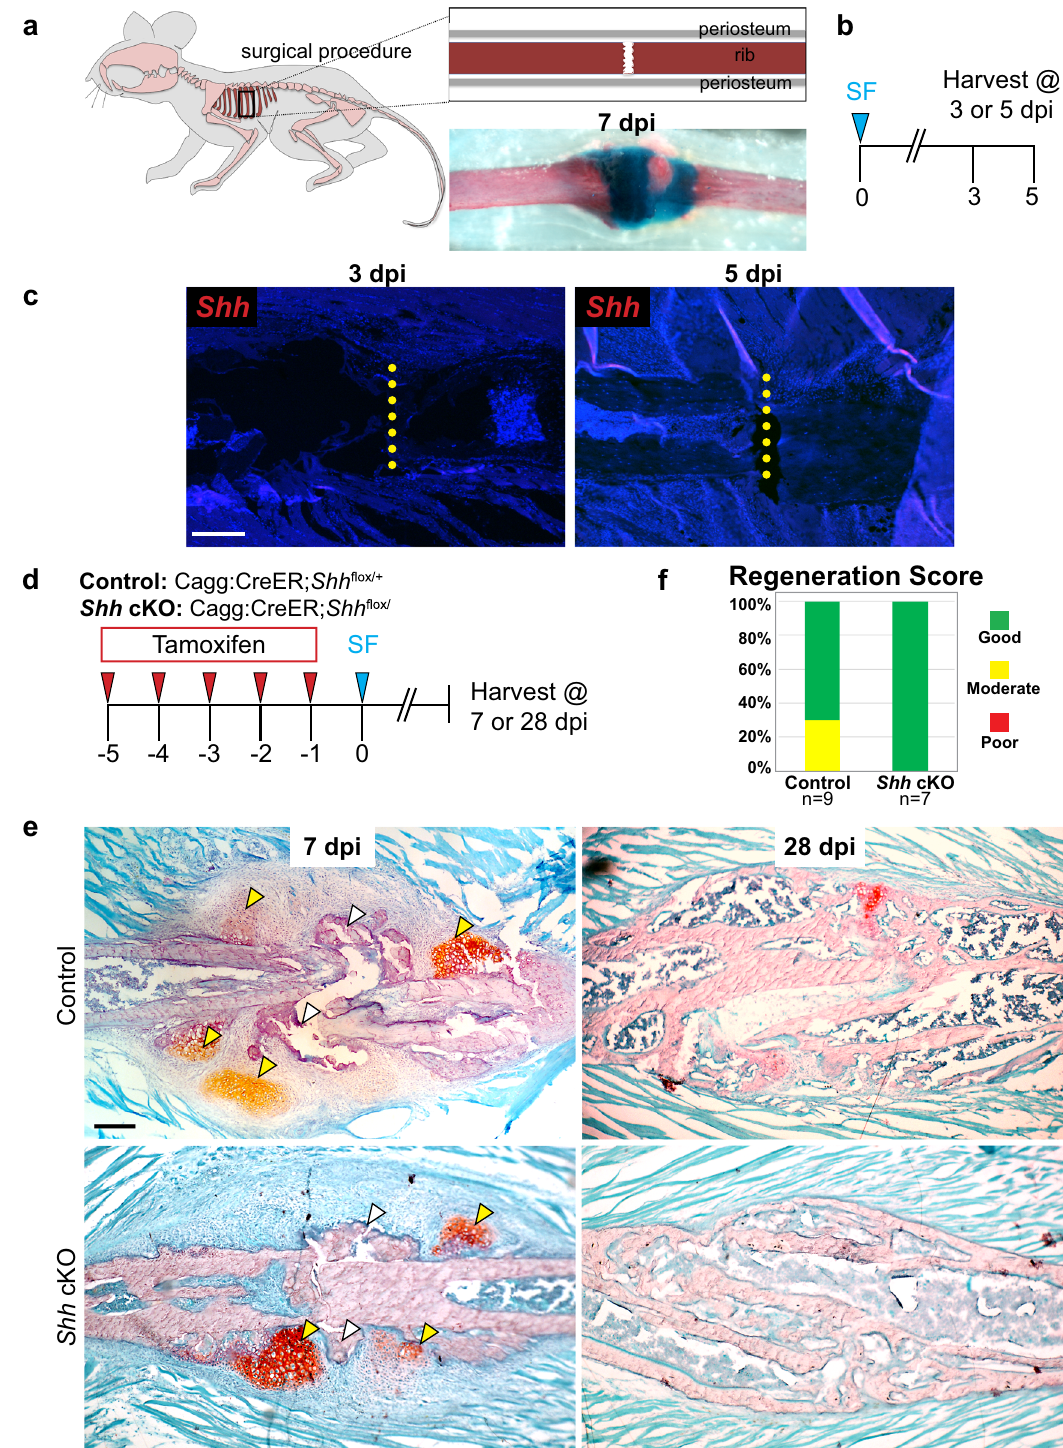
cells at 4 dpi, and performed scRNAseq using the 10x Genomics Chromium platform (Fig. 9b). We chose 4 dpi as it is within the critical window for Hh activation. UMAP visualization identi fi ed ~17 transcriptional cell states broadly representing the major cell types expected, including connective, endothelial, hematopoietic, and muscle cells (Fig. 9c, Supplementary Fig